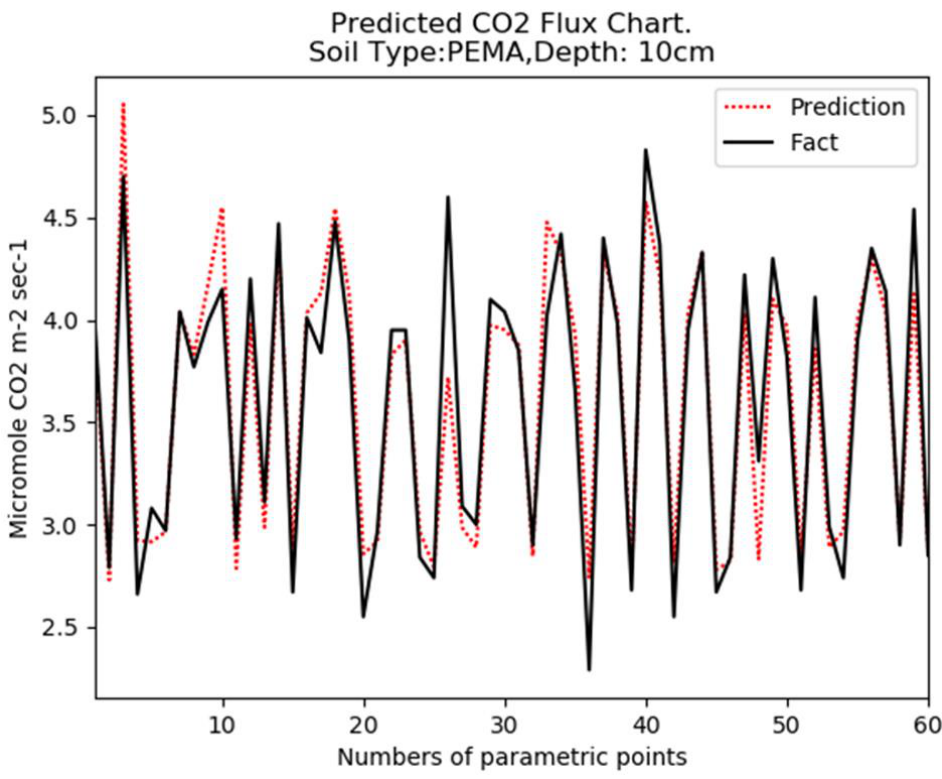
Figure 5. Regression approximation results in experiment 4.